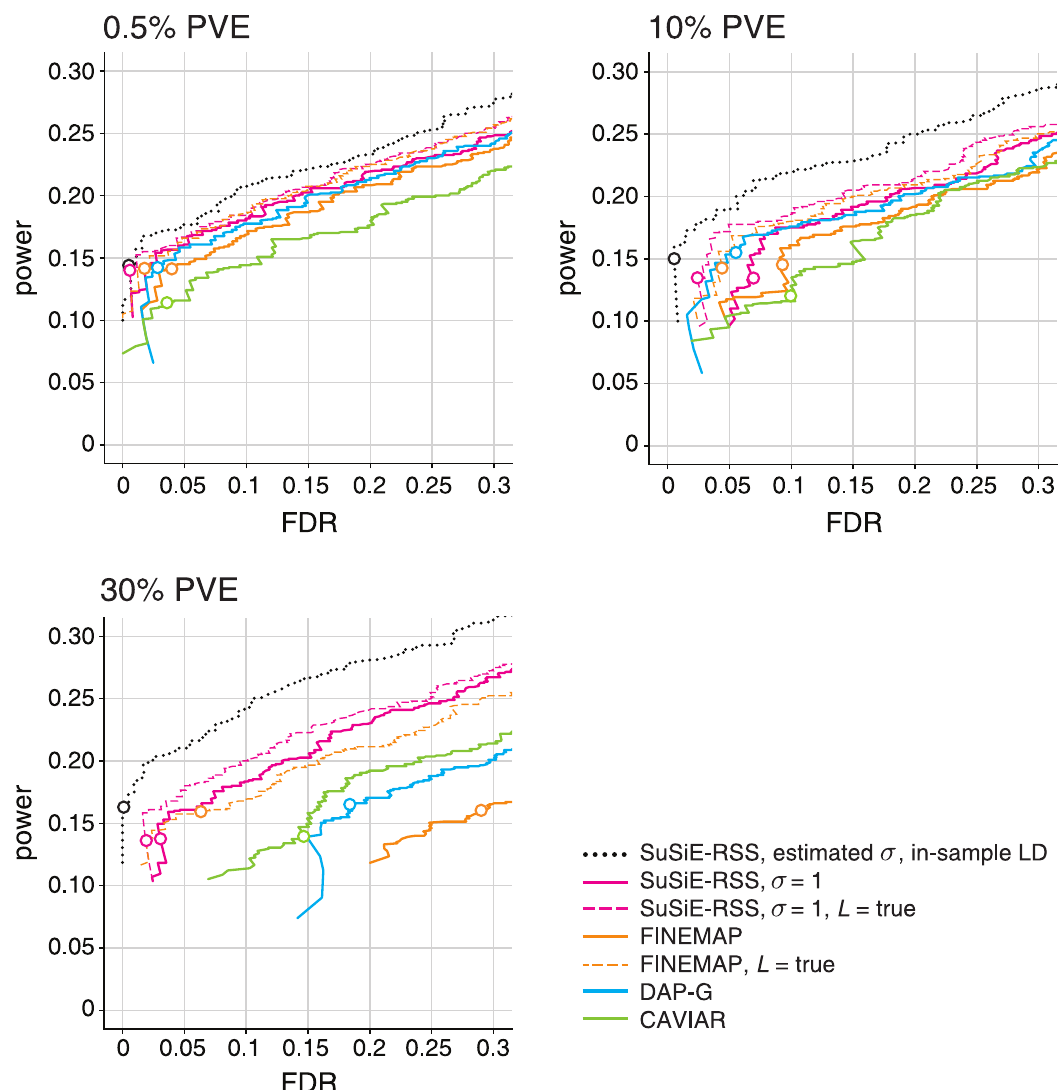
Fig 6. Discovery of causal SNPs using posterior inclusion probabilities—Out-of-sample LD and larger effects. Each curve shows power vs. FDR for identifying causal SNPs with different effect sizes (total PVE of 0.5%, 10% and 30%). Each panel summarizes results from 600 simulations; FDR and power are calculated from the 600 simulations as the PIP threshold is varied from 0 to 1. Open circles depict power and FDR at a PIP threshold of 0.95. In addition to comparing different methods ( SuSiE-RSS . FINEMAP, DAP-G, CAVIAR), two variants of FINEMAP and SuSiE-RSS are also compared: when L , the maximum number of estimated causal SNPs, is set to the true number of causal SNPs; and when L is larger than the true number. SuSiE-RSS with estimated residual variance σ 2 and in-sample LD (dotted black line) is shown as a “best case” method against which other methods can be compared. All other methods are given an out-of-sample LD matrix computed from a reference panel with 1,000 samples, and with no regularization ( λ = 0). The simulation results for 0.5% PVE (top-left panel) are the same as the results shown in previous plots (Figs 3 and 5), but presented differently here to facilitate comparison with the results of the higher-PVE simulations.